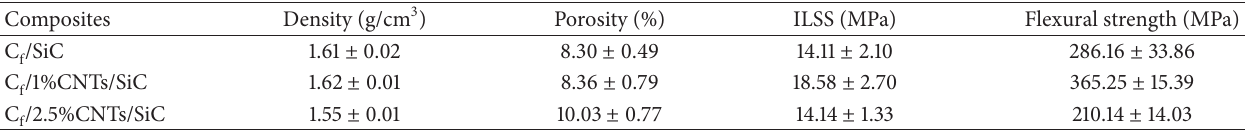
/SiC, C /1%CNTs/SiC, and C f f